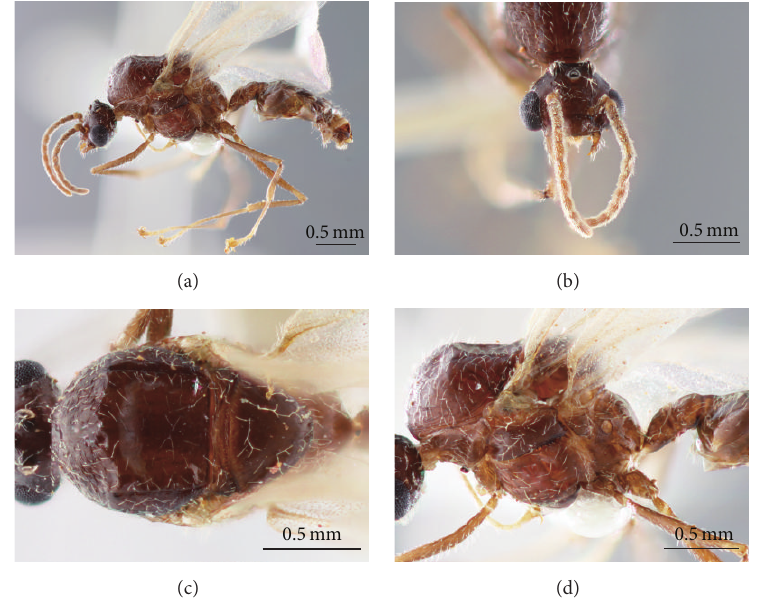
Figure 4: Crematogaster coriaria , Mayr, 1872, male: (a) body in lateral view; (b) full-face view of head; (c) dorsal view of mesosoma; (d) lateral view of mesosoma, petiole, and